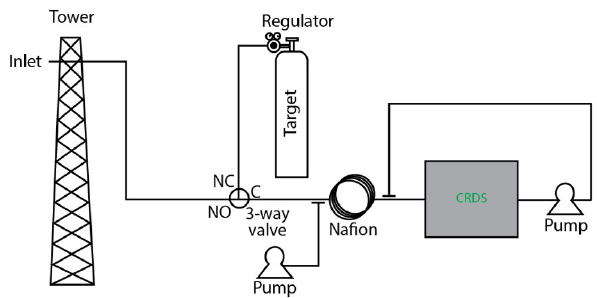
Figure 2. Schematic of the systems deployed in the field. The Hobbs site has additional inlets at 2ma . g . l . and inside the build- ing, and associated valves as shown in Fig. 2b in Richardson et al.